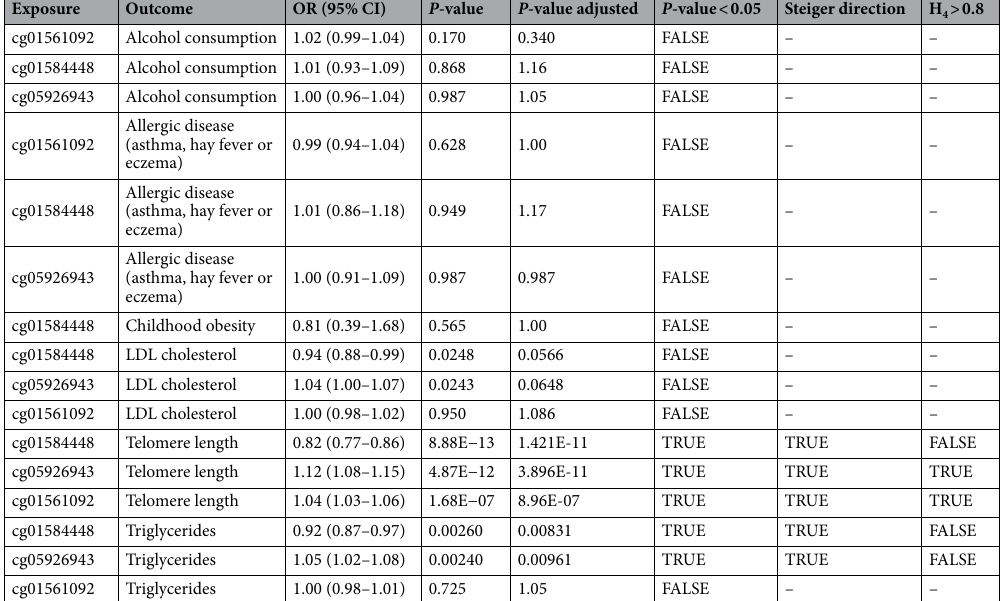
Table 4. The Mendelian randomization, colocalization and Steiger filtering results for the MR analysis of DNAm on glioma related traits. OR odds ratio (95% confidence intervals [CI]) per 1 standard deviation change in genetically proxied DNA methylation.